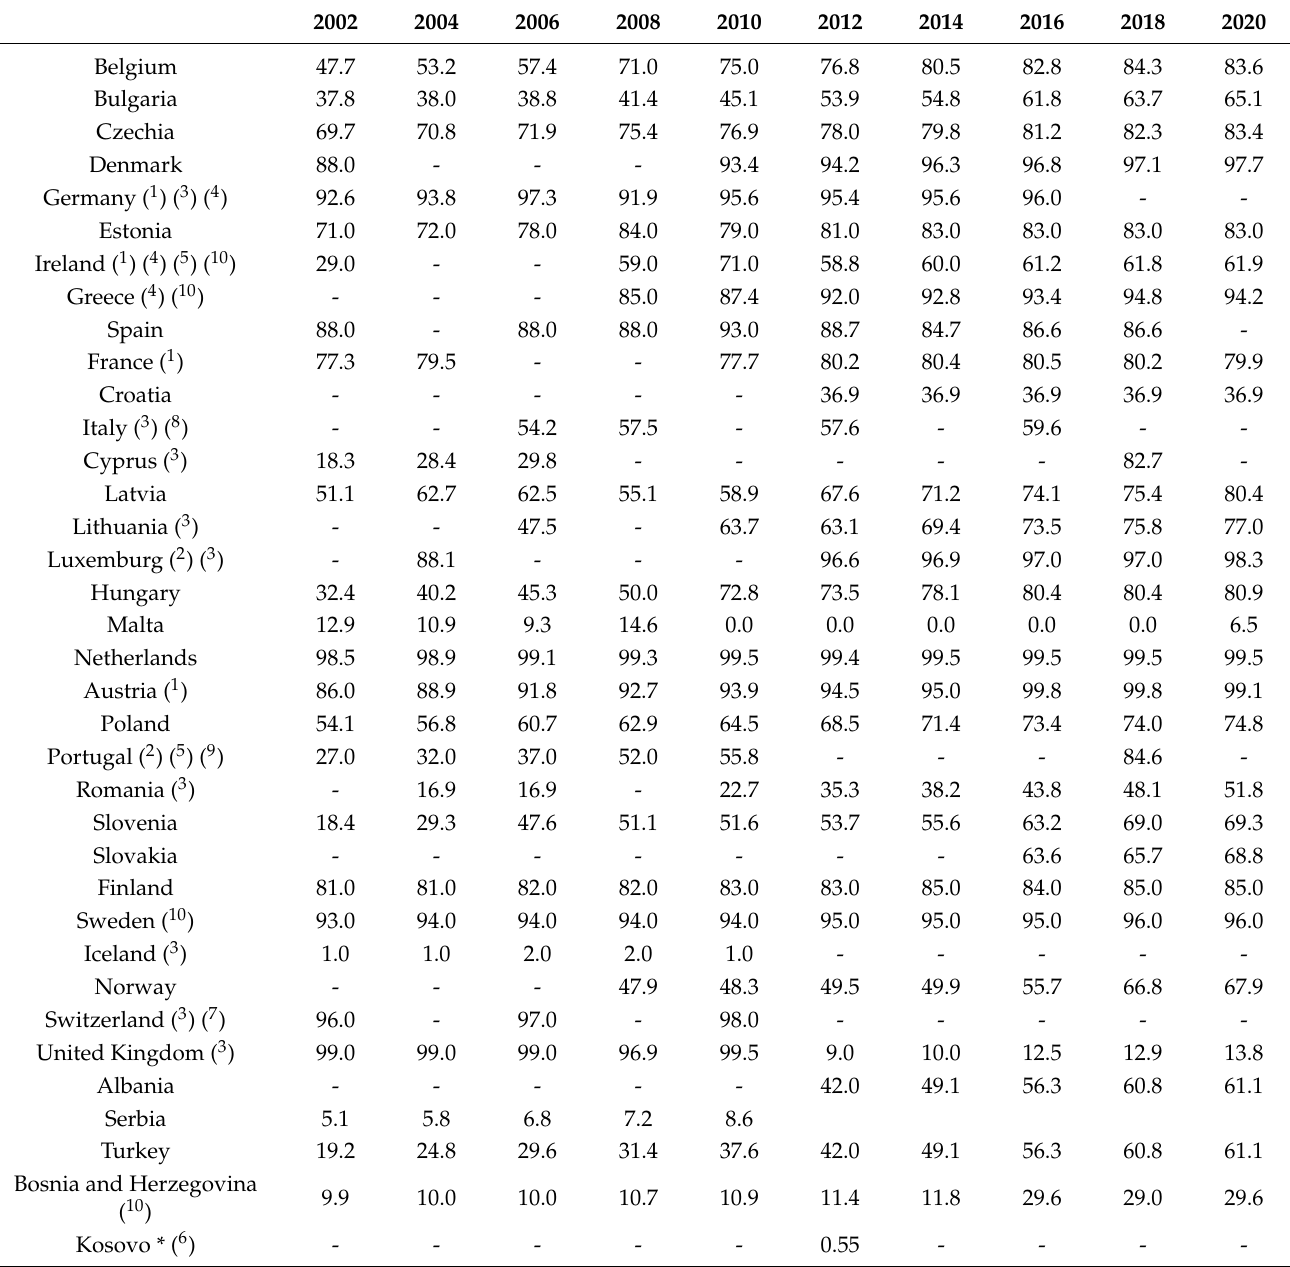
Table 1. Share of the population with access to urban wastewater treatment plants, 2002–2020 (%) (data from